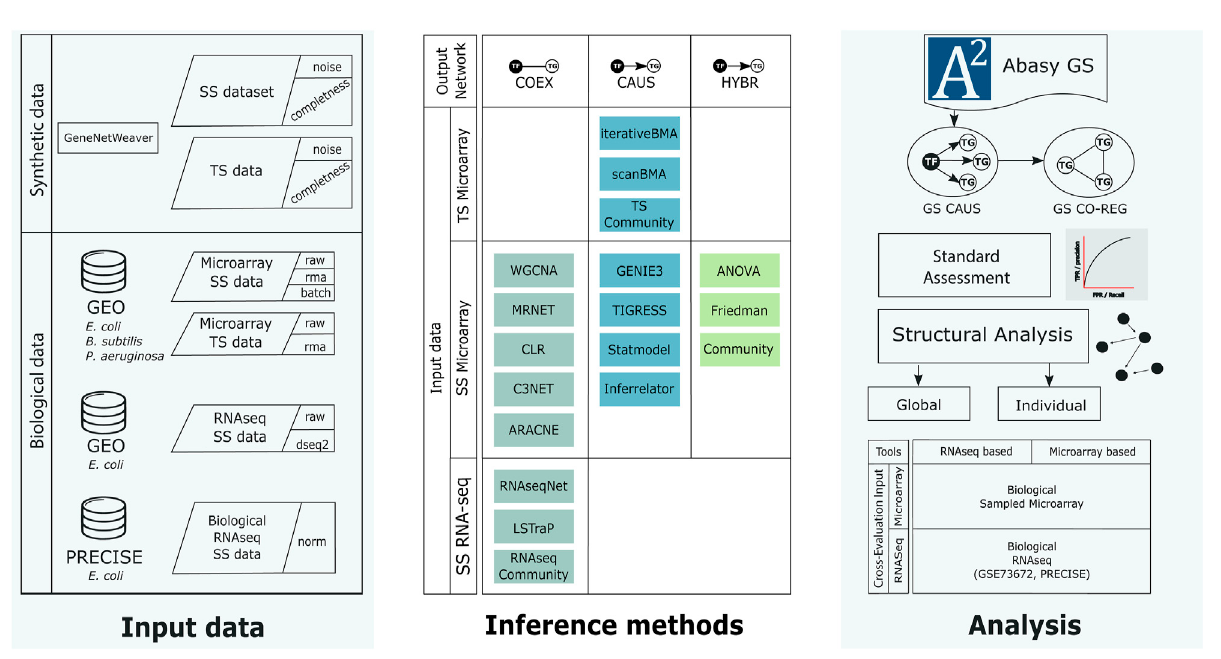
FIGURE 1 Work fl owofthiswork.WegeneratedsyntheticdatausingGeneNetWeaverfor E.coli andcollectedseveralbiologicalmicroarraydatasetsfromGEO for E.coli,B.subtilis, and P.aeruginosa ,aswellasRNA-seqdatafromGEOandPRECISEfor E.coli (leftcolumn).Thesyntheticandbiologicaldatasetswere used as input for the inference methods (middle row). The inference methods were classi fi ed according to their fi nal network type. COEX tools generate undirected networks. CAUS tools generate directed networks using a list of regulators to compute the predictions as part of their algorithm. HYBR includes Friedman and ANOVA implementations (Zorro-Aranda et al., 2022) that generate co-expression networks that are trimmed to only include regulations mediated by a known transcription factor. The Community networks are classi fi ed according to the type of tools they include. We used biological networks as the gold standard to perform the assessment and analyses (right column). From the directed gold standard ( “ CAUS ” GS) we generated a co-regulation gold standard (GS CO-REG). We performed the standard statistical and a structure-based assessment. SS: steady-state data, TS: time-series data, GS: gold standard, TF: transcription factor, TG: target gene. See Supplementary Figure S1 for further